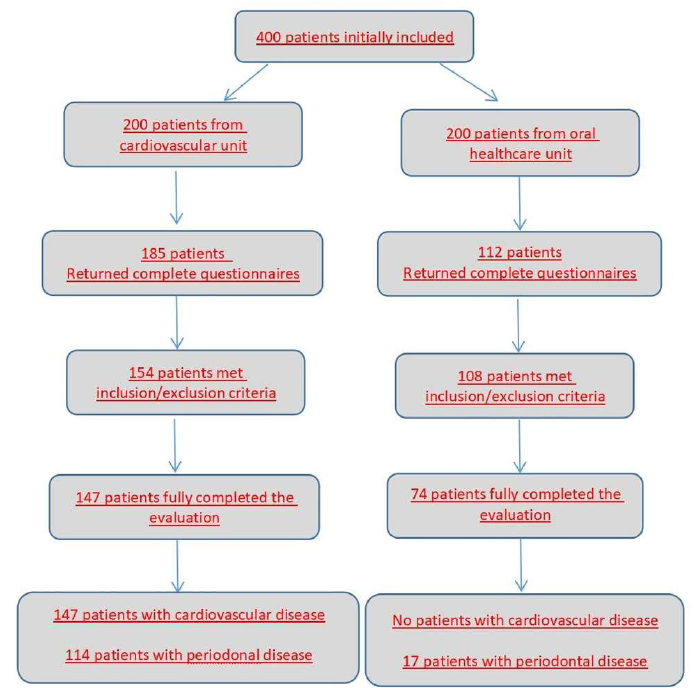
Figure 1. Patient selection.